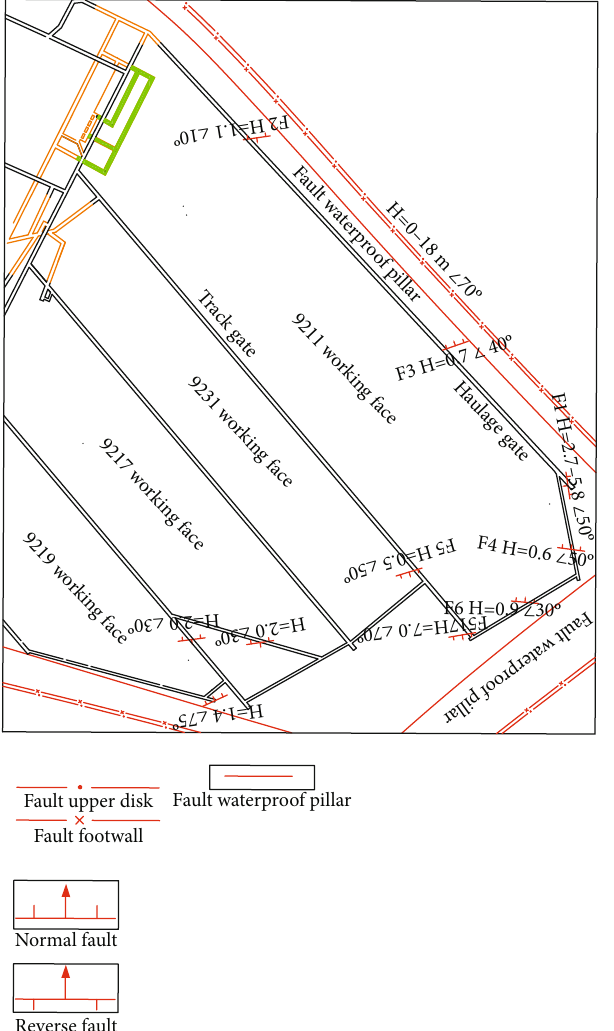
Figure 2: Working face layout in the Bucun Coal Mine.